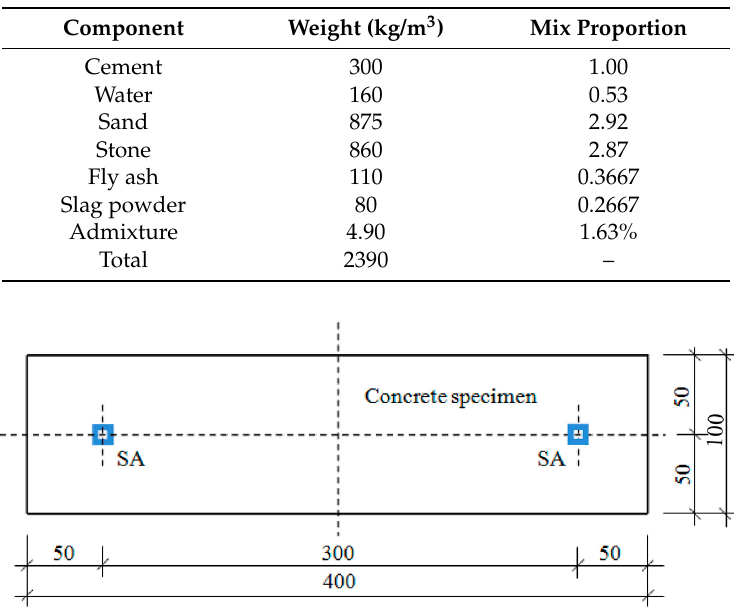
Table 1. Compositional details of the concrete.